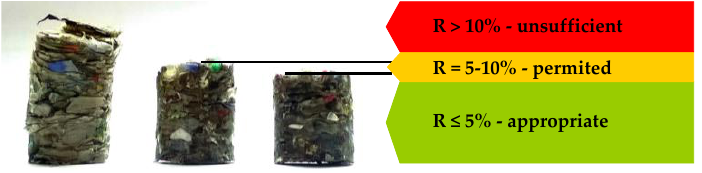
Figure 9. Variation of specific density with compaction pressure, temperature, and pellet diameter. The grey line in each plot represents the average value of each group. Top and bottom of each box represents range of values deviation. Figure 10. Pellet quality criterion based on the expansion coefficient.